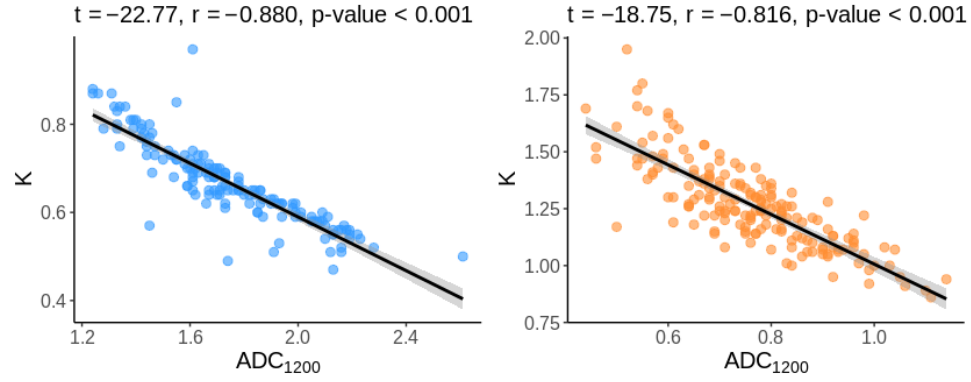
Figure 3. Relationship between ADC 1200 and K for control tissue (left in blue) and for cancerous tissue (right in orange).